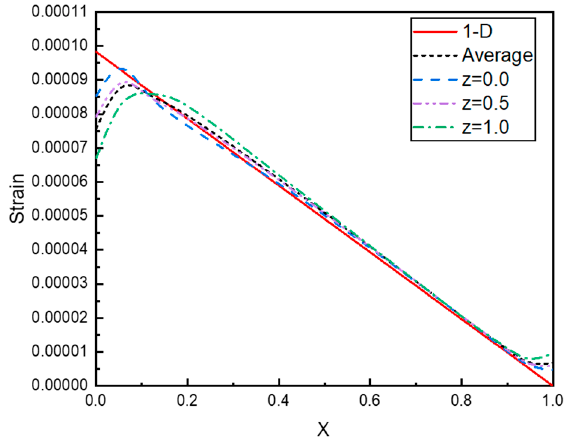
Figure 5. Strain distributions along the x axis on the upper surface for δ = 7.5 μ m.